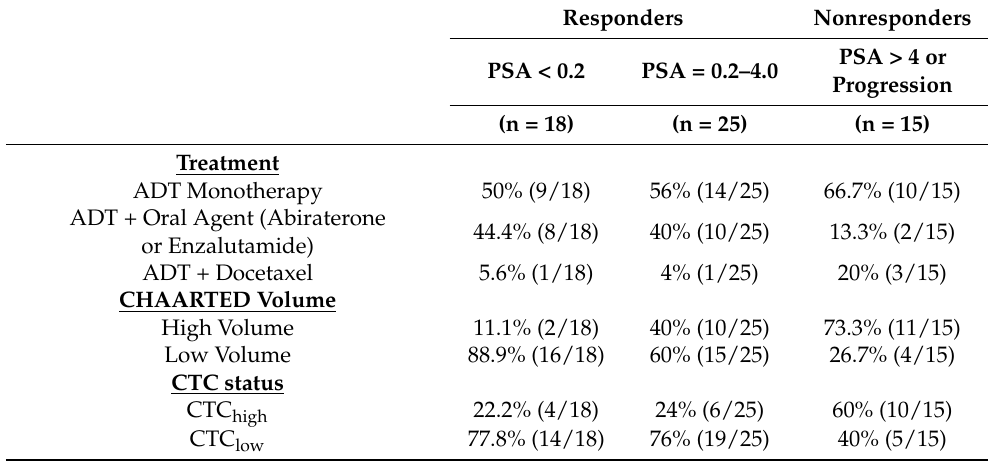
Table 2. Patient outcomes at 7 months following initiation of ADT.